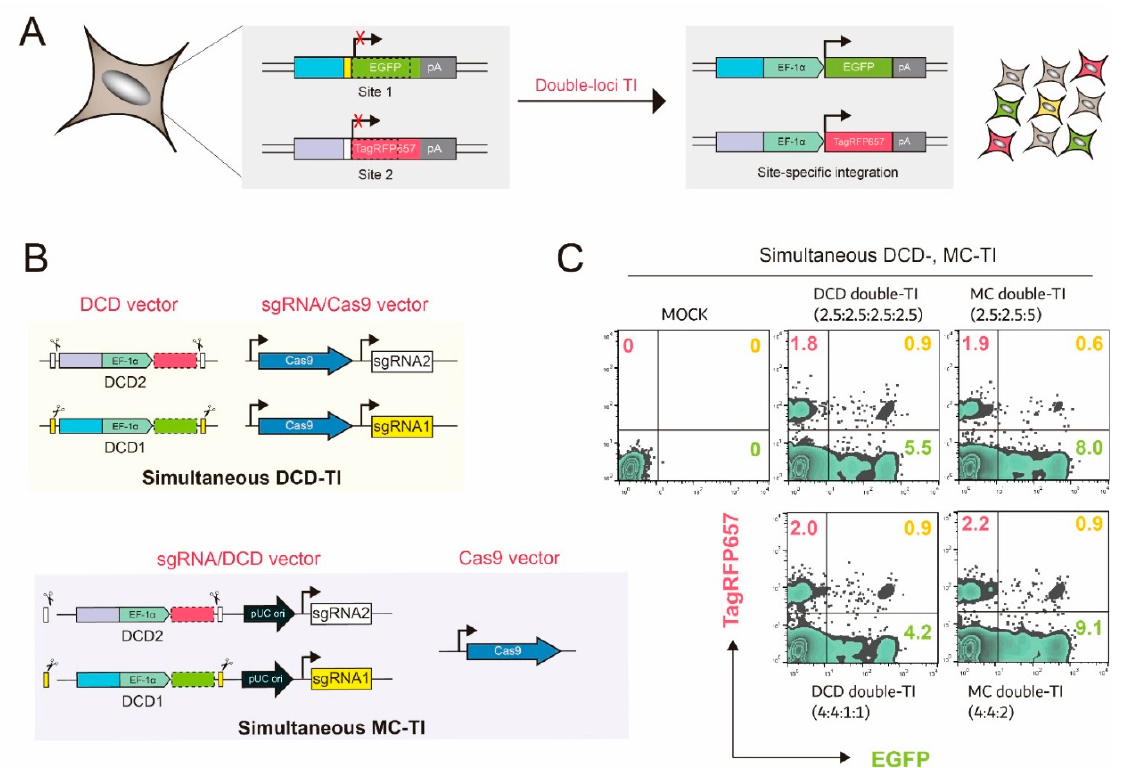
Figure 4. Application of the multi-component (MC) system to double-targeted integration (TI). ( A ) Schematic diagram of promoter trap-based double-TI monitoring CHO-K1 cell line and ( B ) vector constructs needed for double TI in DCD and MC system. The two genomic site-specific sgRNA/protospacer adjacent motif sequences were included in the corresponding targeting DCD templates (DCD1 and DCD2). ( C ) Simultaneous DCD- and MC-TI. Following 6-day post-transfection of all vector constructs at once, EGFP and TagRFP657 expression levels were quantified using flow cytometry. Two different ratios (w/w) were tested in each DCD and MC system and the simultaneous DCD–TI (2.5:2.5:2.5:2.5, w/w/w/w) was set as a control value. Representative dot plot images from three independent experiments are shown with mean values. n = 3.